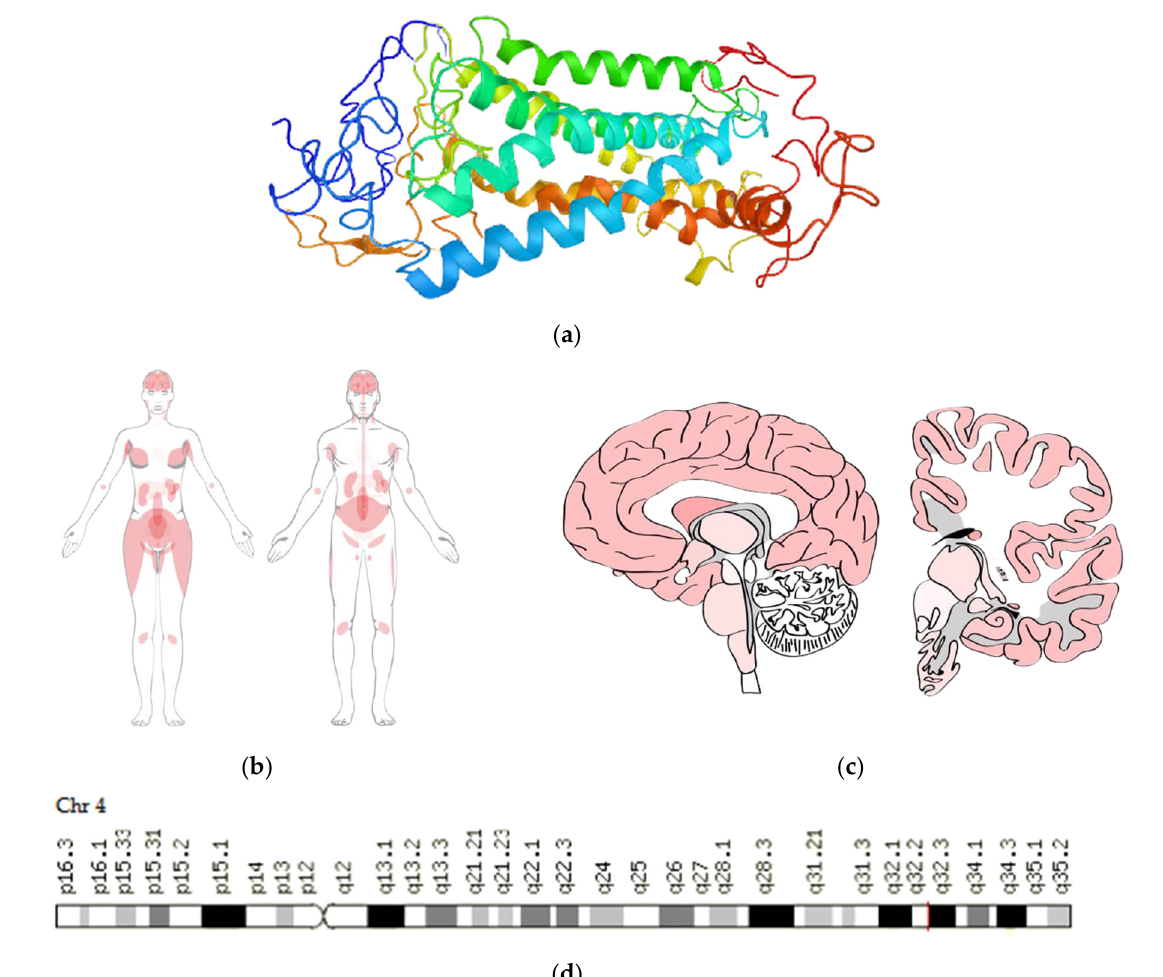
Figure 2. Structure ( a ) and tissue expression ( b , c ) of a neuropeptide Y receptor Y5 [6]; chromosome location of the NPY5R gene ( d ) [9].